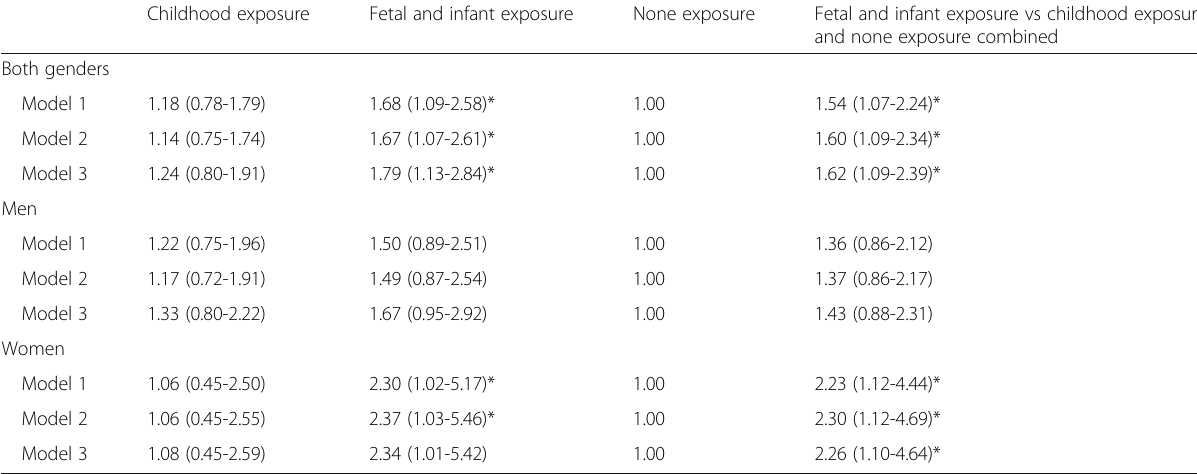
Table 3 Association (odds ratio (95% CI)) between early life famine exposure and self-reported hypertension Childhood exposure Fetal and infant exposure None exposure Fetal and infant exposure vs childhood exposure and none exposure